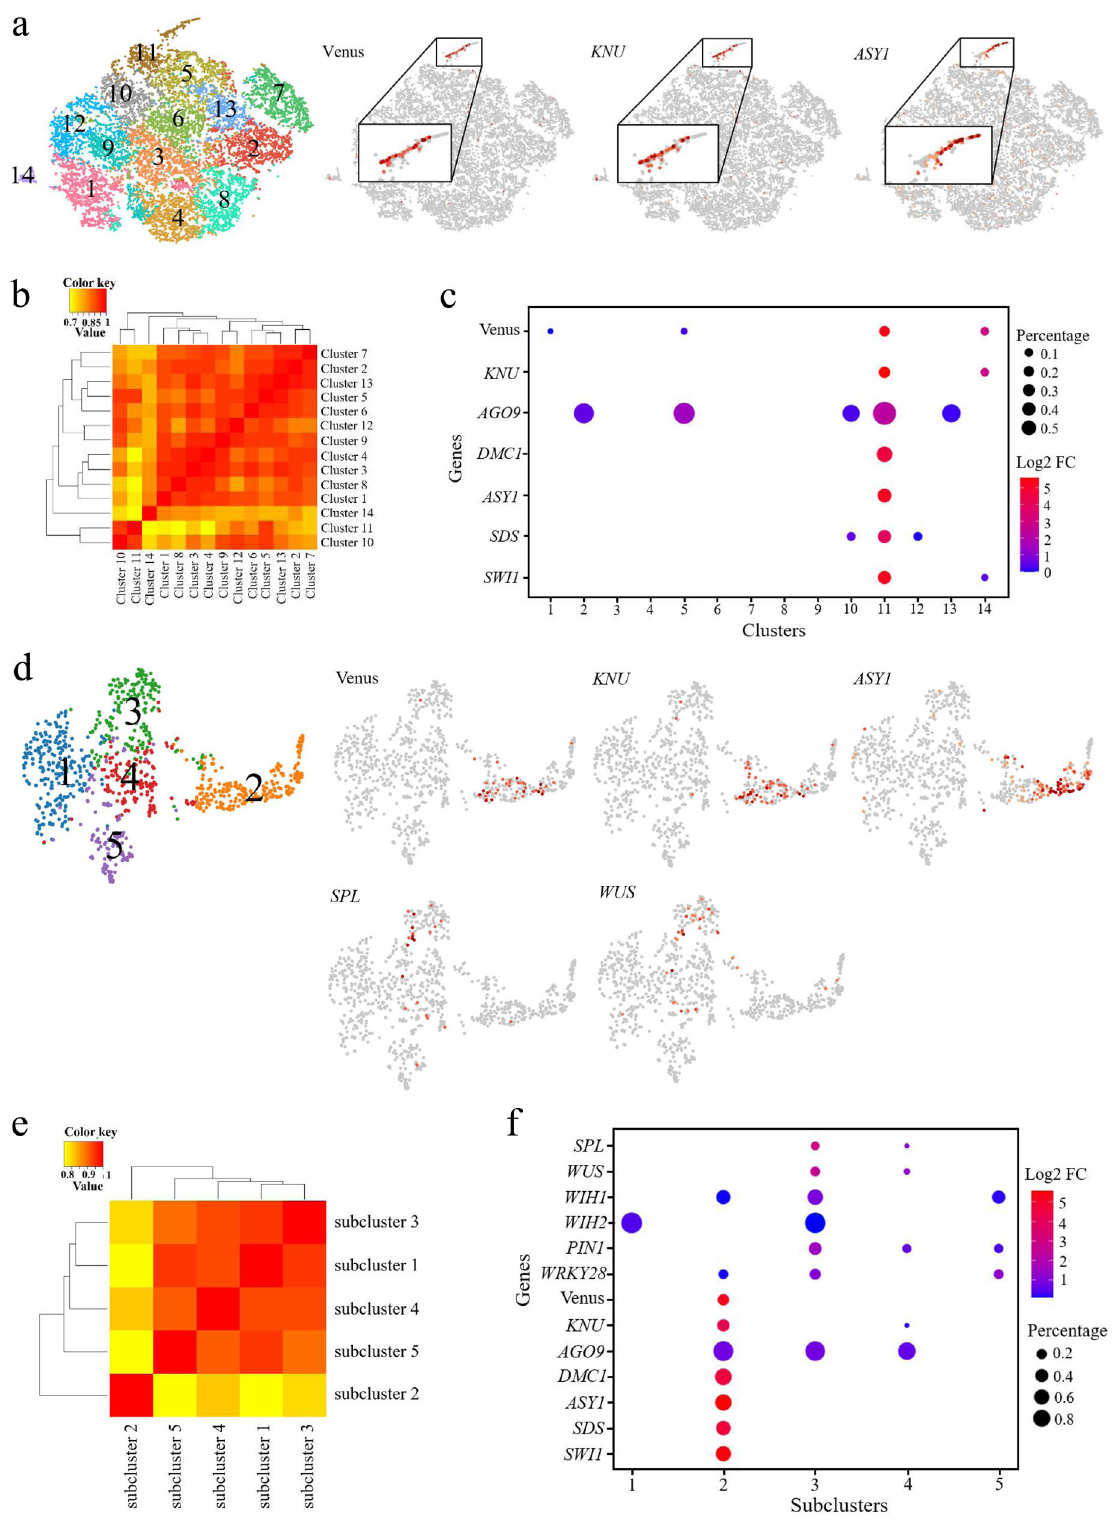
examined in the epidermis of the distal nucellus, while pERL2:GFP was located in the epidermis of the inner integument. In the MMC2 stage and post-meiotic stage of ovules, both pER:GFP and pERL2:GFP displayed preferentially expression in the epidermis of distal nucellus cells and the inner integument (Fig. 9c). The epidermal nucellus cell preferential expression pattern of the ERECTA gene family is consistent with the results of cell clustering analysis, implying